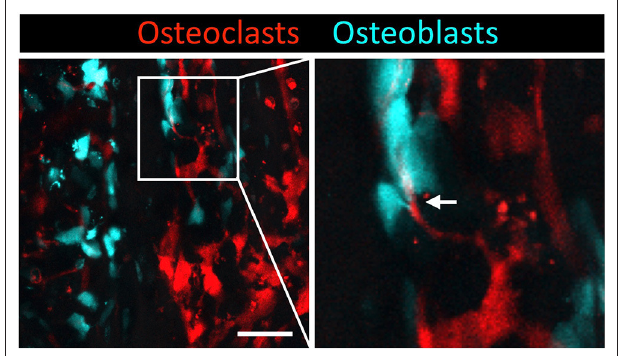
FIGURE 2 | Intravital imaging of mature osteoclasts and osteoblasts in the bone marrow. Images of the calvaria of TRAP-tdTomato/Col2.3-ECFP double fluorescently labeled mice taken via two-photon microscopy. Scale bar: 50 µ m. Maximum intensity projections (MIPs) of two-dimentional image stacks of vertical calvarial slices. Mature osteoclasts express TRAP-tdTomato signals (red) and mature osteoblasts express Col2.3-ECFP signals (cyan). Arrowhead indicates the direct osteoclast-osteoblast